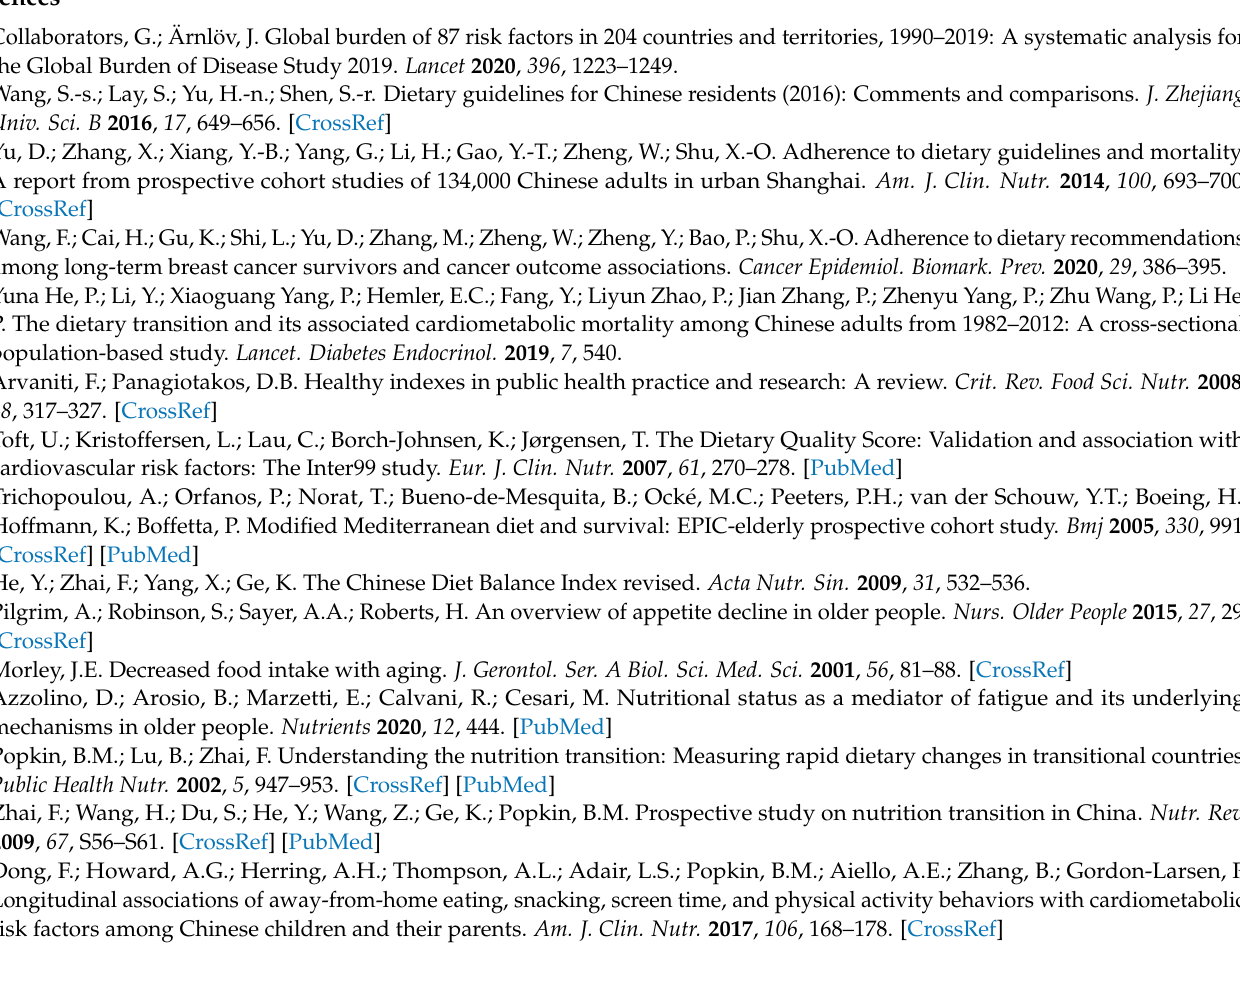
Figure A3. Weight of each food as a percentage of the total weight of all food groups within the range of DNAS .